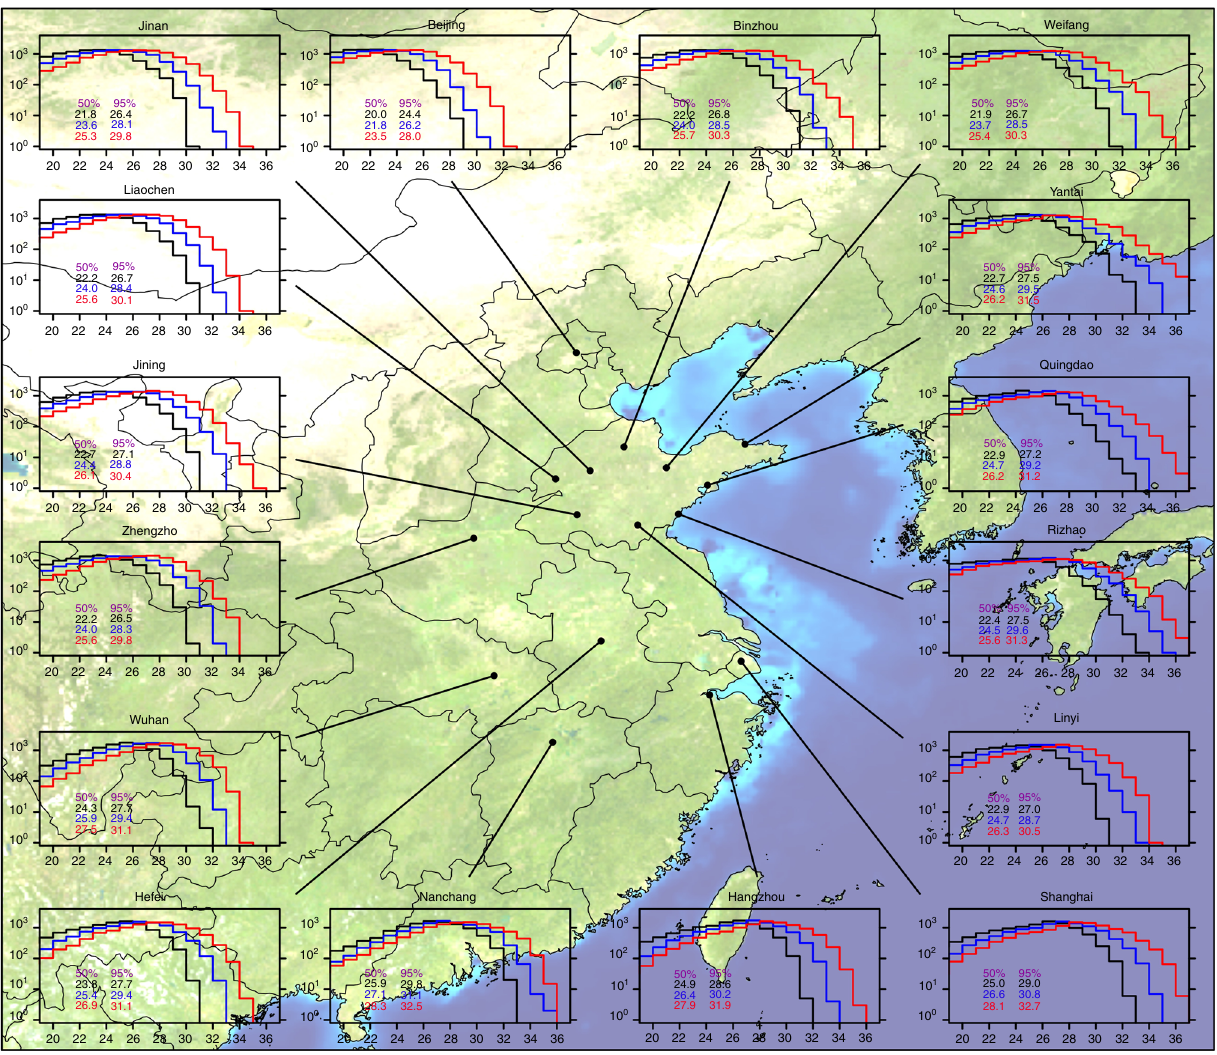
Fig. 3 Histogram of daily maximum wet-bulb temperature in 16 cities over Eastern China. Histogram of the JJAS season of TW max (°C) for each GHG scenario ’ s ensemble: historical (black), RCP4.5 (blue), and RCP8.5 (red). The histogram bin interval is 1.0 °C and the values on the y -axis indicate the number of exceedances. Values indicated within each plot represent the 50th and 95th percentile event thresholds. TW max is the maximum daily value from 6-h running average for each day (bias correction described in the Methods section). The fi gure was created using the NCAR Command Language (https://www.ncl.ucar.edu), but the background image was obtained from NASA Visible